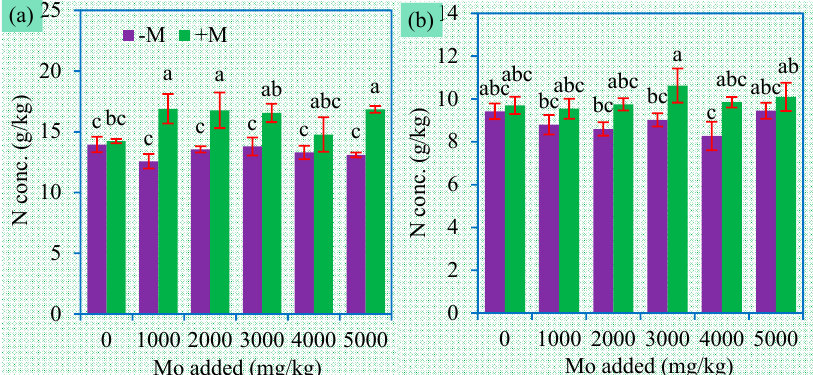
Figure 6. Shoot ( a ) and root ( b ) N concentrations (mean ± SE, n = 4) of sweet sorghum exposed to different concentrations of Mo. -M and +M represent non-AM inoculation and inoculation with Claroideoglomus etunicatum BEG168, respectively. Different letters over the bar represent significant differences between the means among different treatments using one-way ANOVA followed by Duncan’s multiple range test ( p < 0.05). Two-way ANOVA results for shoot N concentrations: AM inoculation: F = 31.8**, Mo: F = 0.9 ns, AM×Mo: F = 1.7 ns; two-way ANOVA results for root N concentrations: AM inoculation: F = 15.3**, Mo: F = 1.3 ns, AM × Mo: F = 0.9 ns. Significance levels: * p < 0.05; ** p < 0.01; ns non-significant effect.